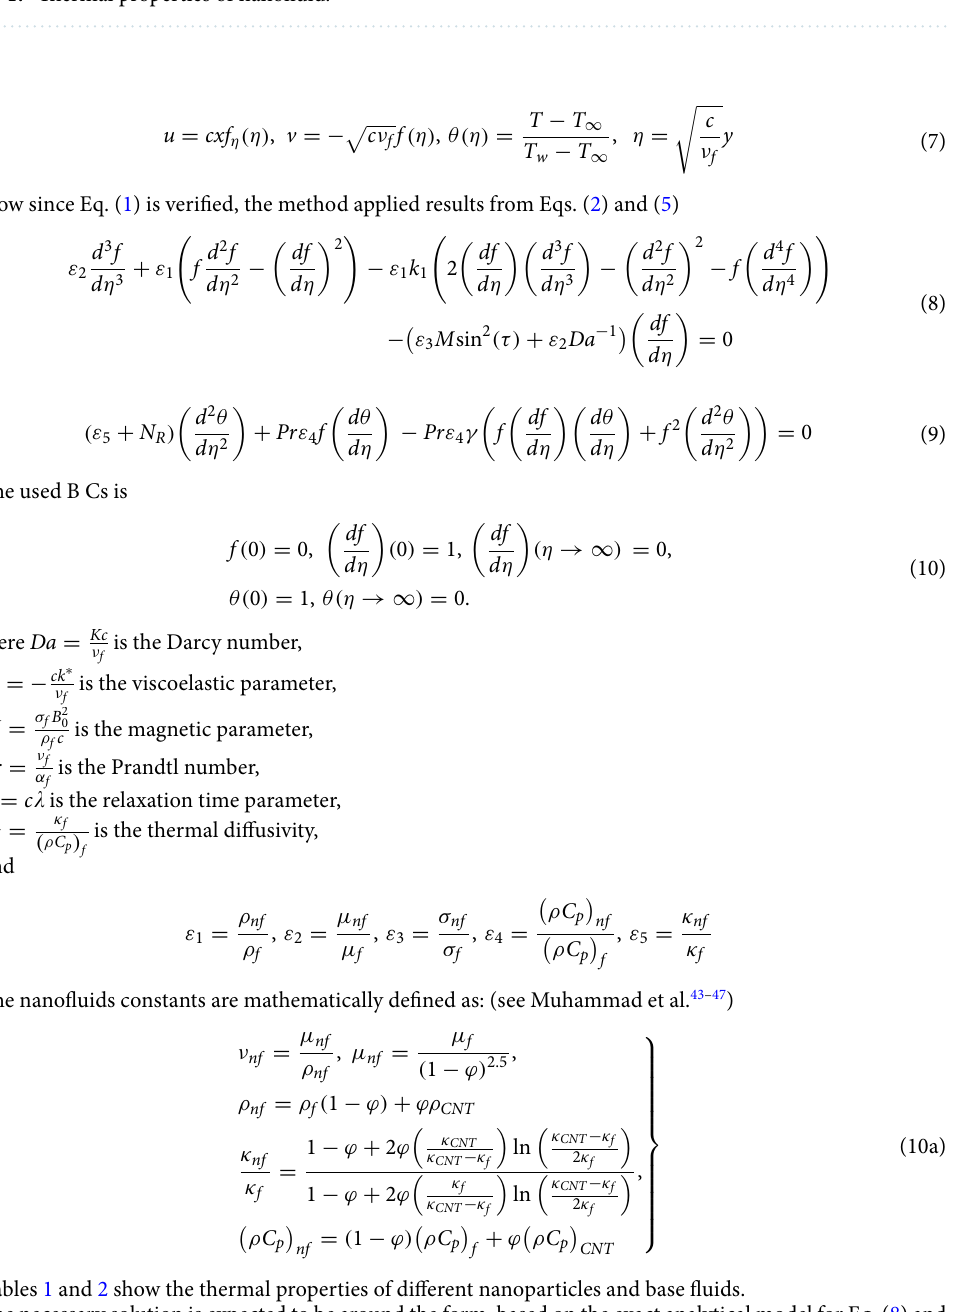
Table 1. Thermal properties of